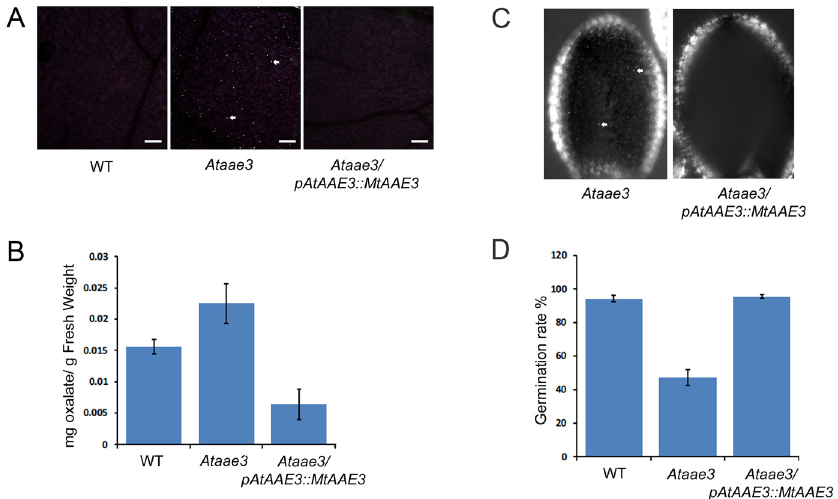
Fig 4. Complementation of Ataae3 with Mt AAE3 under the control of the AtAAE3 promoter. (A) Calcium oxalate crystal leaf phenotype of WT, Ataae3 , and Ataae3 /p AtAAE3 ::GFP- Mt AAE3 Arabidopsis. Crystals are bright spots designated by arrows. (B) Oxalate concentrations in leaves from WT, Ataae3 , and Ataae3 /p AtAAE3 ::GFP- Mt AAE3 Arabidopsis. (C) Complementation of Ataae3 calcium oxalate crystal seed phenotype through expression of Mt AAE3. Crystals are bright spots designated by arrows. (D) Germination of WT, Ataae3 , and Ataae3 /p AtAAE3 ::GFP- Mt AAE3 seeds. Bar = 50 μ